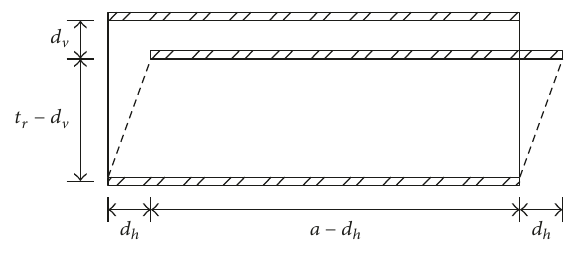
Figure 5: Deformation of single layer rubber.